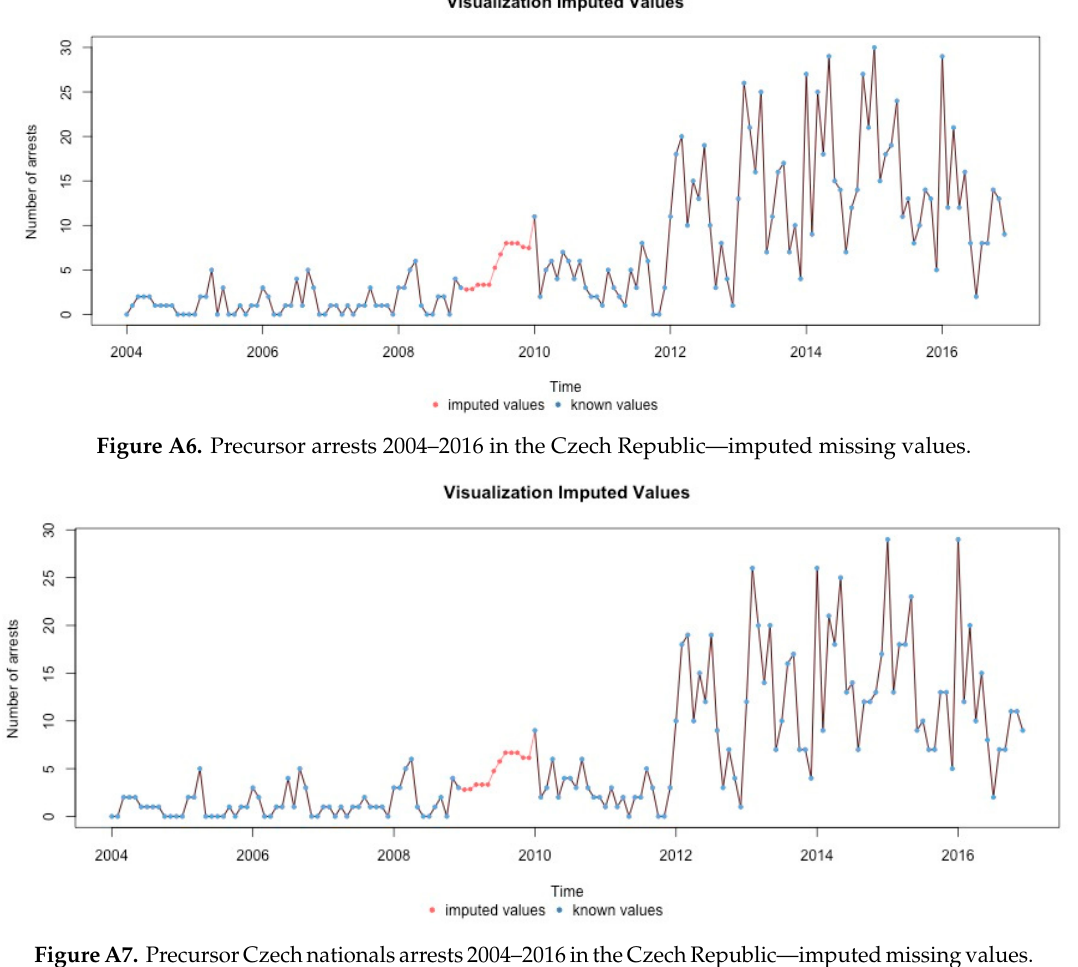
Figure A5. Methamphetamine neighboring countries arrests 2004–2016 in the Czech Republic – imputed missing values.